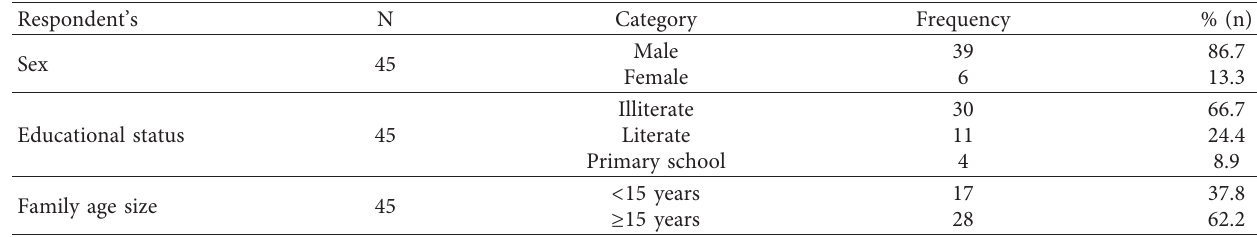
Figure 1: Map of the study area (source: the Table 1: Demographic features of the respondents.